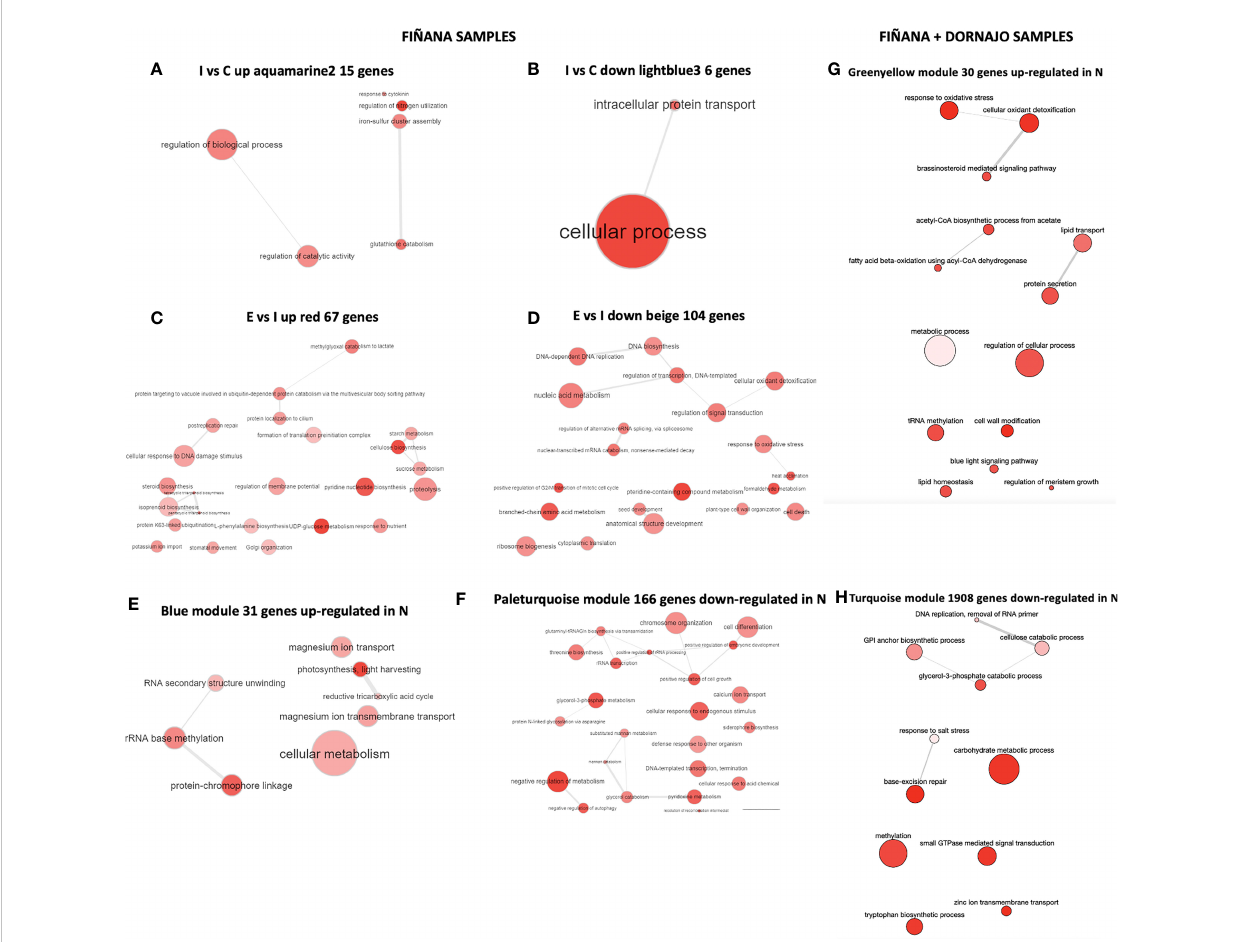
FIGURE 9 GO term enrichment results for the hub genes of the selected modules visualized using REVIGO. (A) Aquamarine module, I vs C up comparison (Fiñana samples). (B) Lightblue3 module, I vs C down comparison (Fiñana). (C) Red module, E vs I up comparison (Fiñana). (D) Beige module, E vs I down comparison (Fiñana). (E) Paleturquoise module, R vs N up comparison (Fiñana). (F) Blue module, R vs N down comparison (Fiñana). (G) Turquoise module, R vs N up comparison (Fiñana + Dornajo). (H) Greenyellow module, R vs N down comparison (Fiñana + Dornajo).